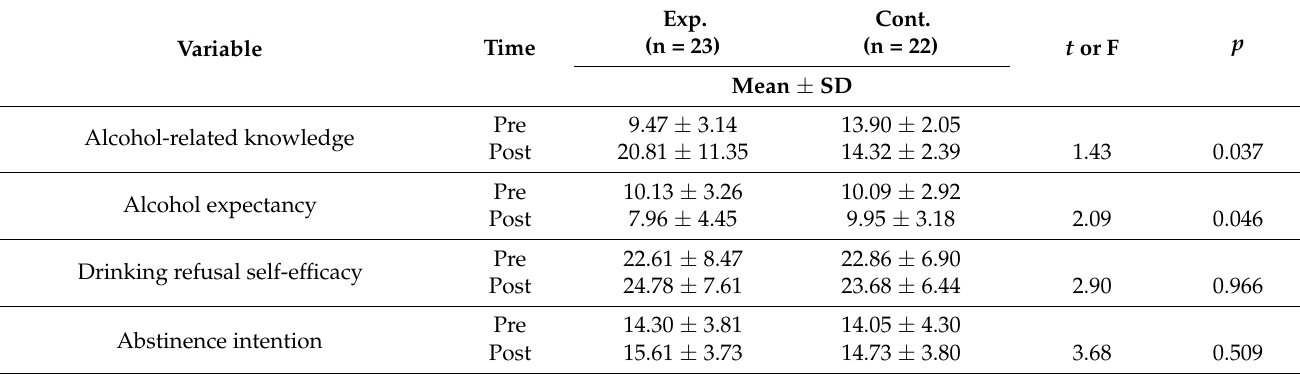
Table 5. Comparison of the differences of dependent variables between groups ( N =